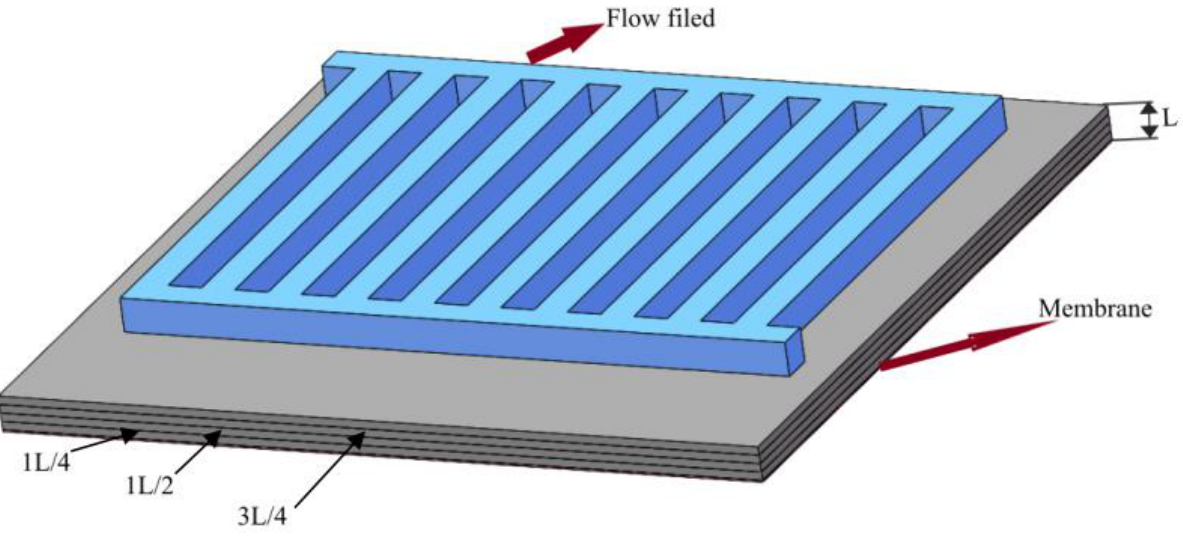
Figure 8. The 2,6-reDHAQ concentration distribution of the 3L/4 cut plane at 0.2 SOC. Figure 9. The 2,6-reDHAQ concentration distribution of the 3L/4 cut plane at 0.6 SOC. For quantitatively evaluating the concentration distribution in different batteries, Figures 10 and 11 show the average concentration variations of 2,6-reDHAQ for the three batteries in different plates under the conditions of SOC = 0.2 and SOC = 0.6. It can be seen from Figures 10 and 11 that the concentration of 2,6-reDHAQ increases when moving from 1L/4 to 3L/4, which is the result of flow resistance. Whether in SOC = 0.2 or SOC = 0.6, the average concentration of the trapezoid section is the highest, under any condition. Therefore, the trapezoid battery can enhance the transport of active ions, so that the trap- ezoid battery can obtain better performance.